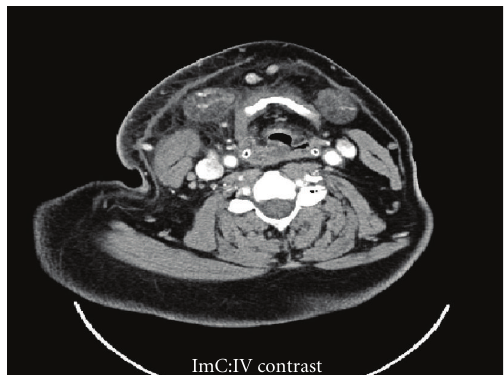
Figure 2: Axial contrast-enhanced CT scan of the patient in Figure 1 showing di ff use swelling of the right submandibular region, stranding of the cervical fat, thickening of the right sterno- cleidomastoid muscle and the right pyriform fossa. The laryngeal airway is mildly e ff aced and displaced